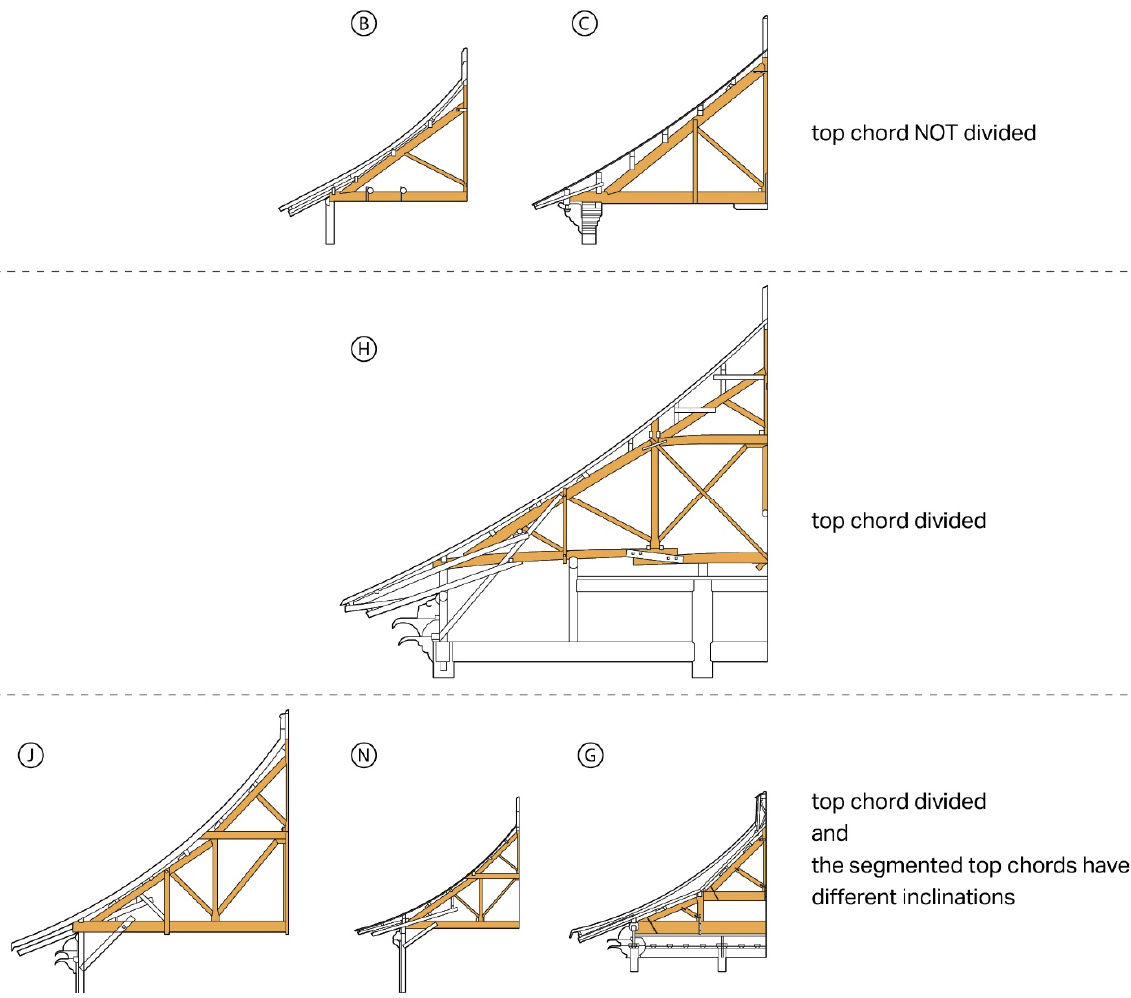
Figure 15. Use of Diagonal Building Components and Influences from Korean Heavy Timber Framing Composition in Hybrid Roof Cases.